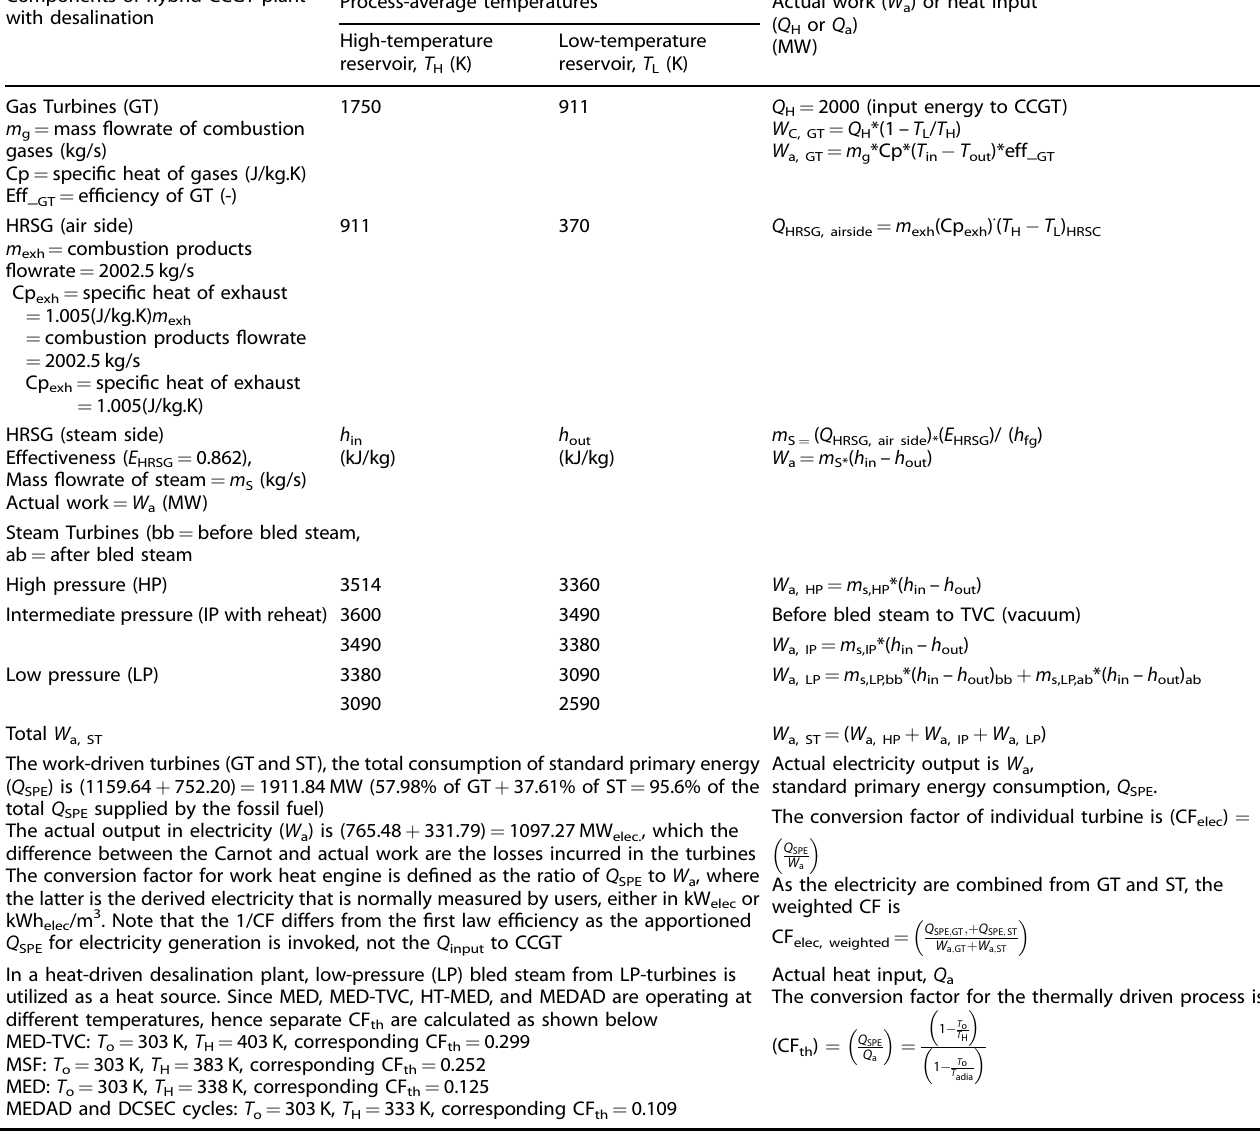
Process-average